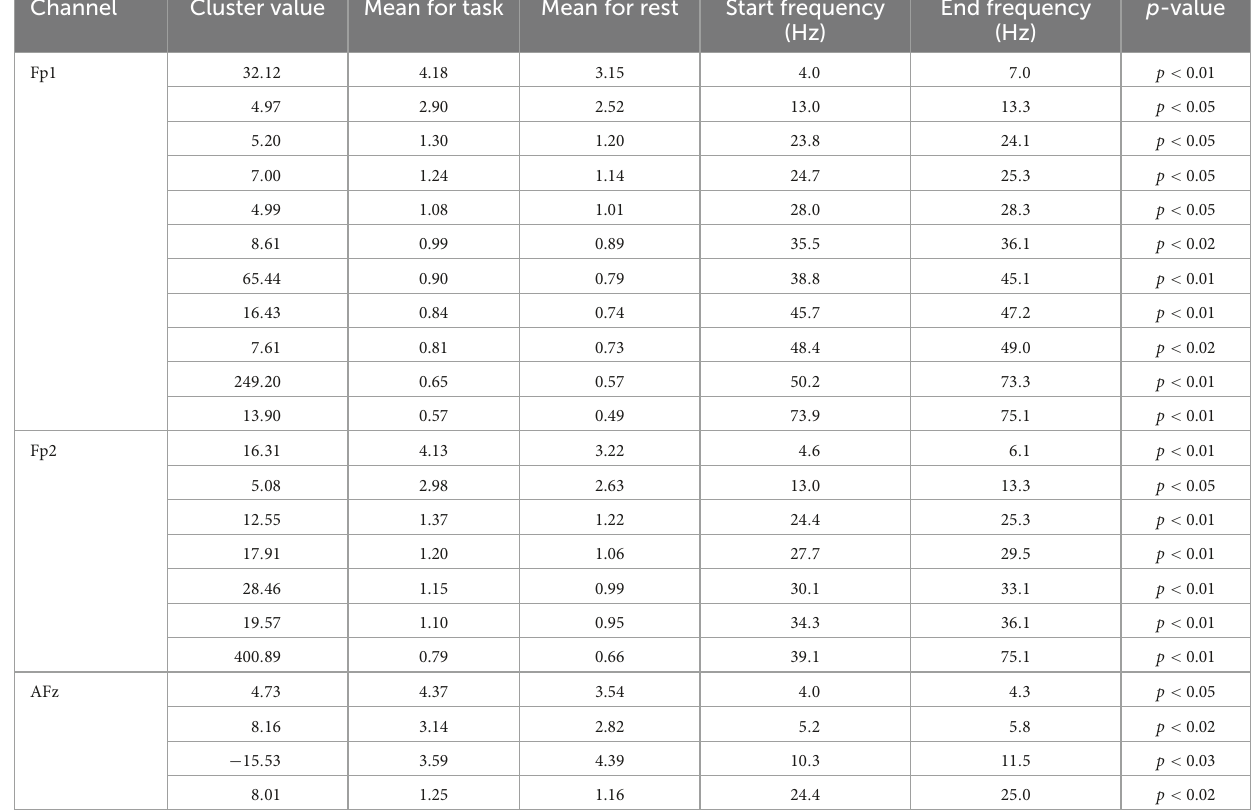
TABLE 1 Results of permutation test in Fm θ group. Channel Cluster value Mean for task